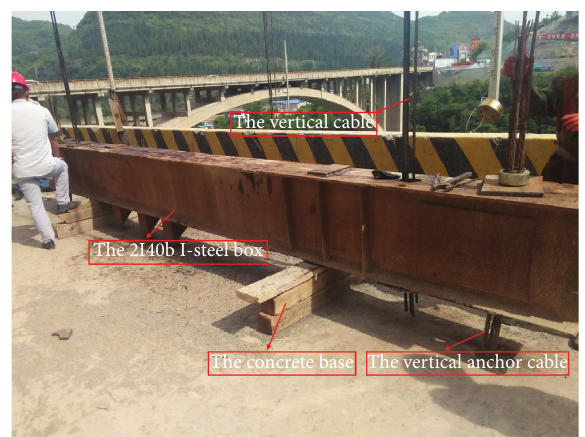
Figure 17: Layout of the anchor end of the hanging basket load test.